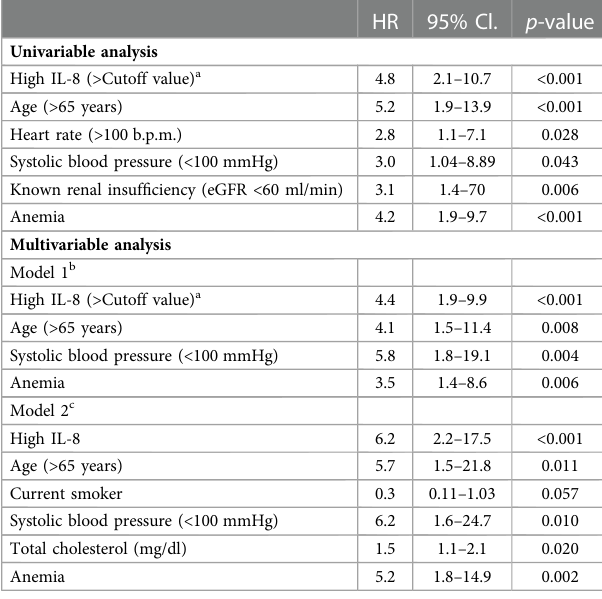
Discussion TABLE 3 Univariable and multivariable HR of high IL-8 for MACEs at 1 year